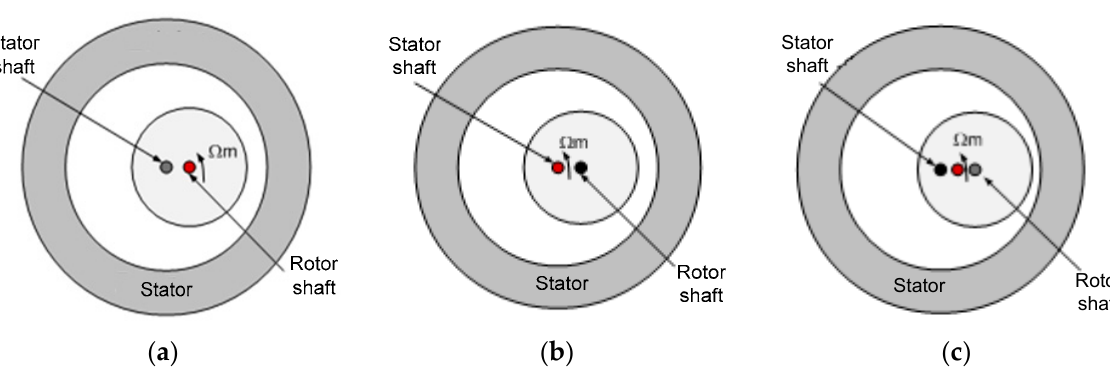
Figure 2. Types of eccentricity: ( a ) static, ( b ) dynamic, and ( c ) mixed. The red shaft represents the rotation axis. The effect of the eccentricities can be taken into account by multiplying the magnetic flux density of the air gap in a machine without eccentricity by (12). This distribution function, (13), defines the variation of the air-gap reluctance due to the eccentricity.